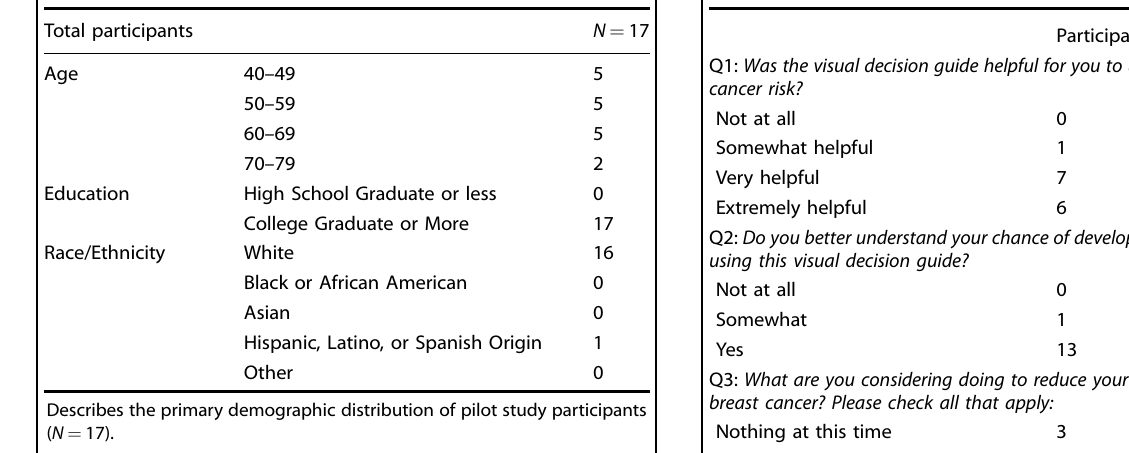
Table 2. Demographic distribution of pilot participants. Table 3. Quantitative feedback survey responses.